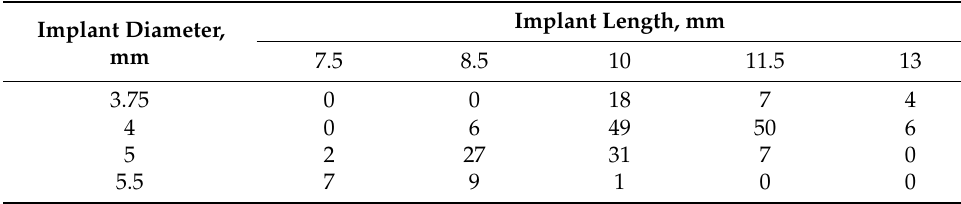
Table 2. Summary of the implant/site distribution.